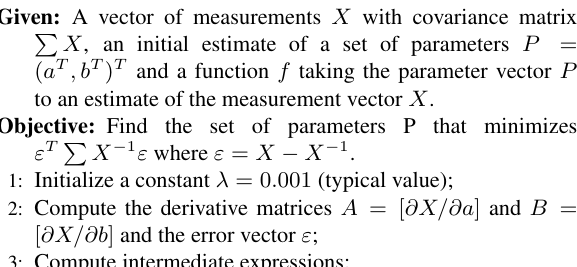
Algorithm 1 Levenberg − Marquardt